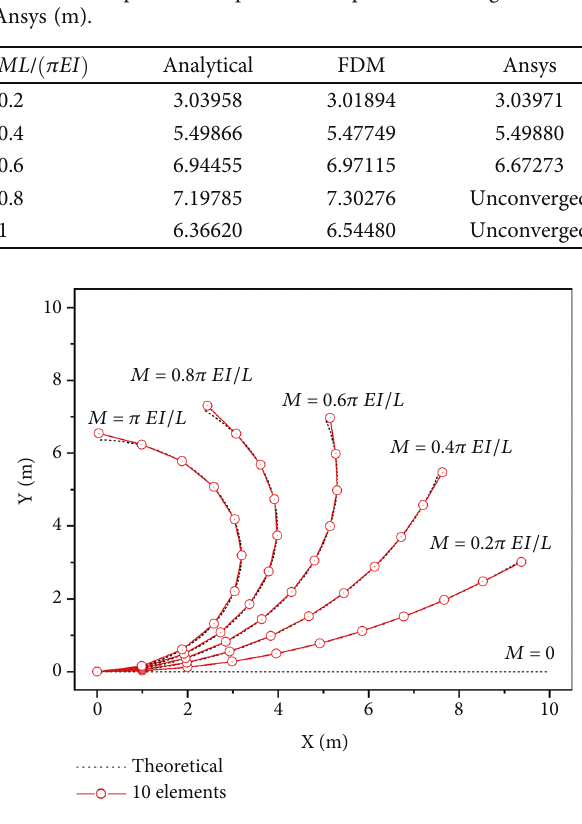
Figure 6: Large deformation of the cantilever under bending